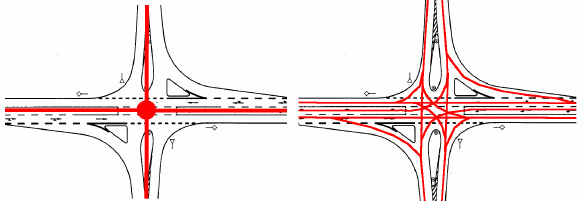
Figure 5. Comparison of the lod0Network and lod3Network representation of an intersection